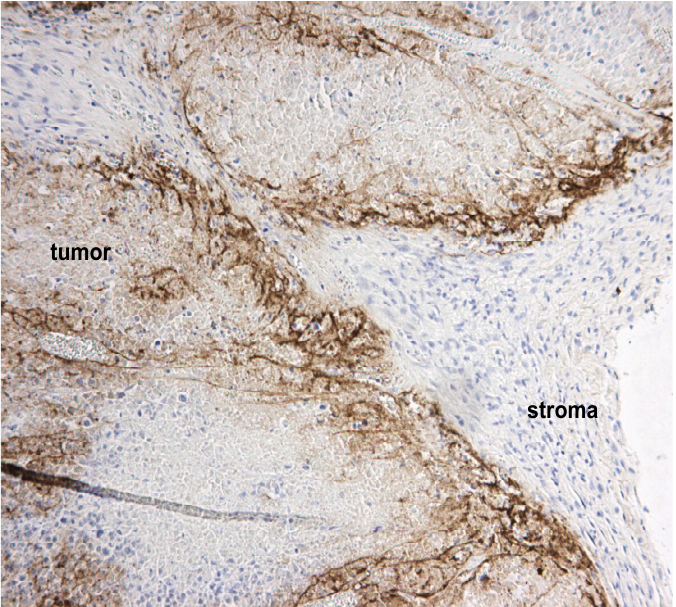
Figure 1. Tumor stroma blocks virus spread within tumors. A representative section of human A2058 melanoma xenografts stained with polyclonal Semliki Forest virus (SFV) antibodies (in brown) shows that even following intratumoral injection, virus infection is delimited by non-permissive stromal cells and the extracellular matrix (collectively called stroma). We have studied these barriers in detail previously